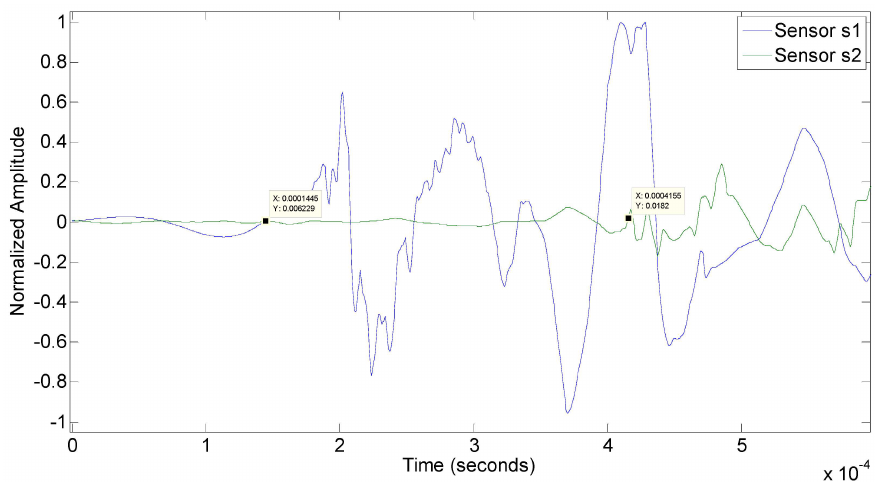
Figure 3. Peak detection of the acoustical emission collected by Sensor 1 ( blue ) and Sensor 2 ( green ) to obtain the experimental propagation velocity in the composite material.